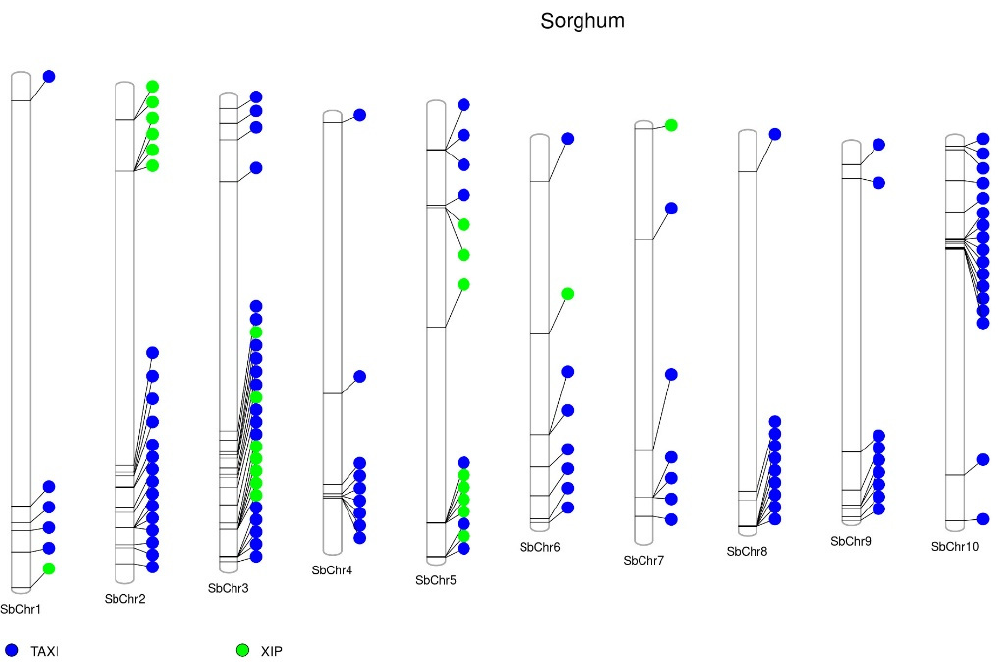
Figure 1. Distribution of xylanase inhibitors (XIs) in sorghum ( Sorghum bicolor ) chromosomes. The publicly available protein sequences of sorghum were downloaded from the Phytozome database (https://phytozome-next.jgi.doe.gov/, accessed on 1 September 2022). The conserved protein do- mains of the XIs were predicted in protein sequences by HMMER software (http://hmmer.org/) us- ing a protein family hidden Markov model (HMM) profile (Pfam) database [38]. SbChr, chromo- some. Web-based interface PhenoGram was used to annotate the genes’ location on the chromosome [40].